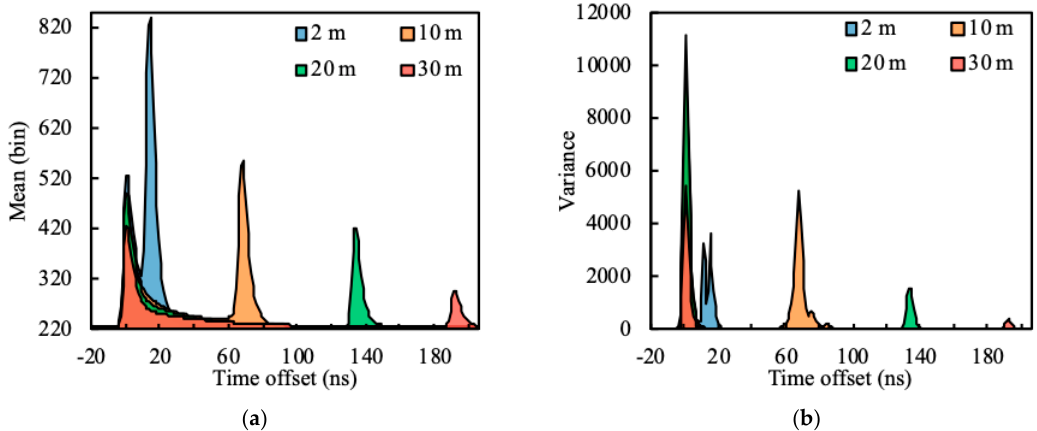
Figure 11. ( a ) Mean curves and ( b ) variance curves of the four bathymetric points. The time offset